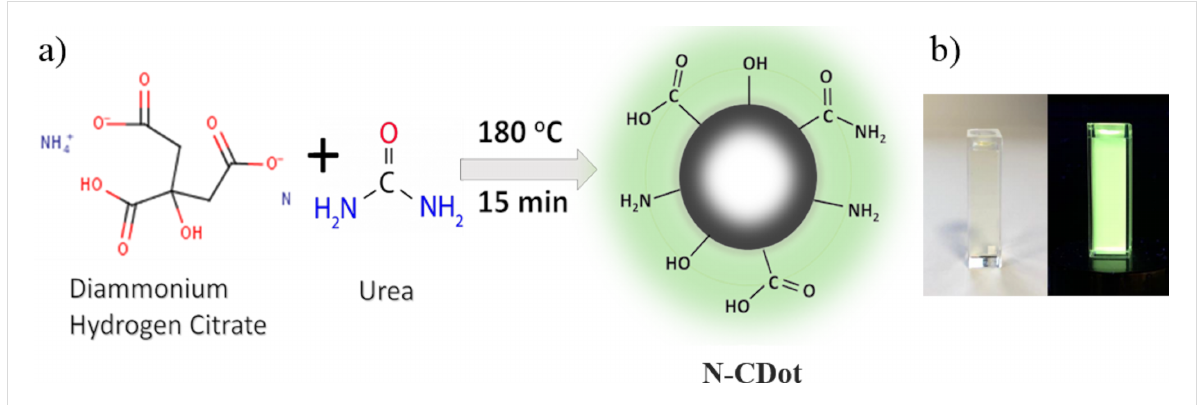
Figure 1: (a) Schematic illustration of the synthesis of the N-CDots and (b) photographic image of the diluted N-CDot suspension under natural light (left) and UV light (right) illumination.